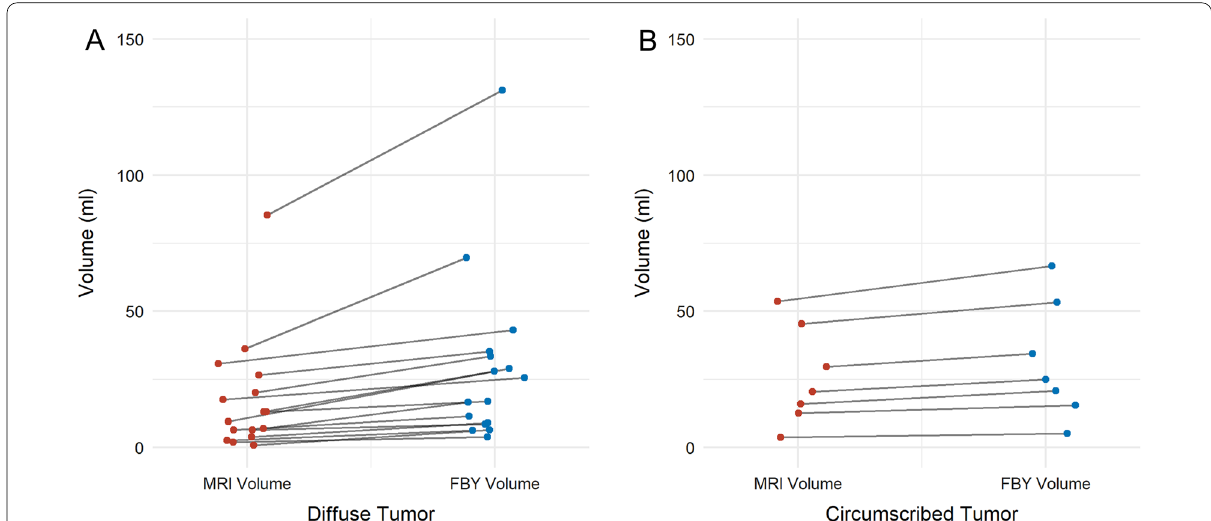
Fig. 3 Volume comparison between diffuse tumors and circumscribed tumors. Each dot represents the individual tumor volume, with lines connecting the value of the same tumor in different segments. Red dots indicate the MRI-based volume, while blue dots represent the FBY-based volume. The diffuse tumors displayed larger volume changes between MRI-based volume and FBY-based volume than circumscribed